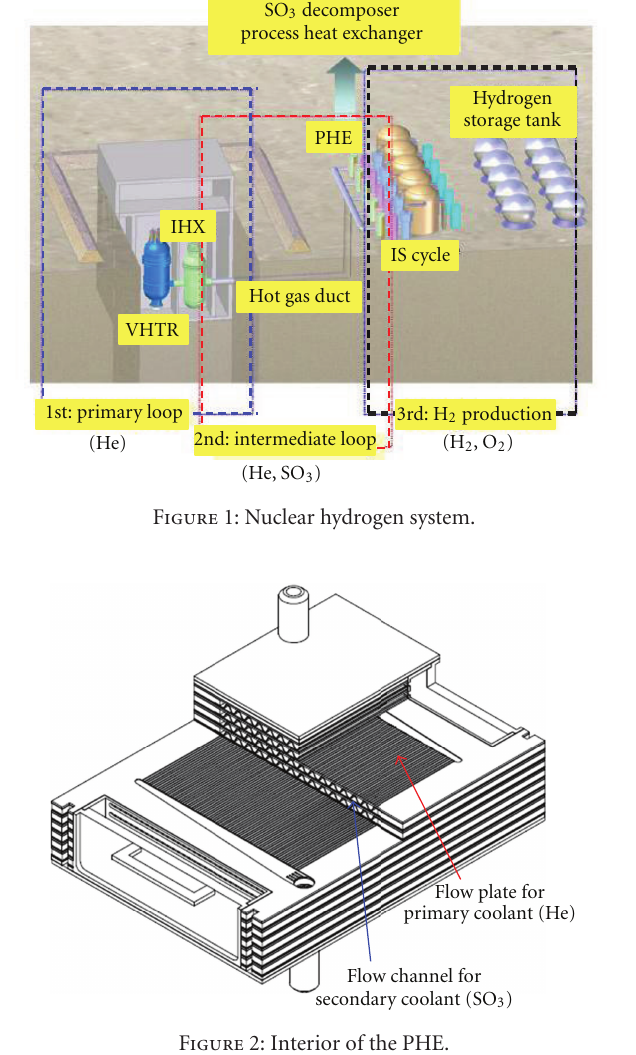
Figure 2: Interior of the